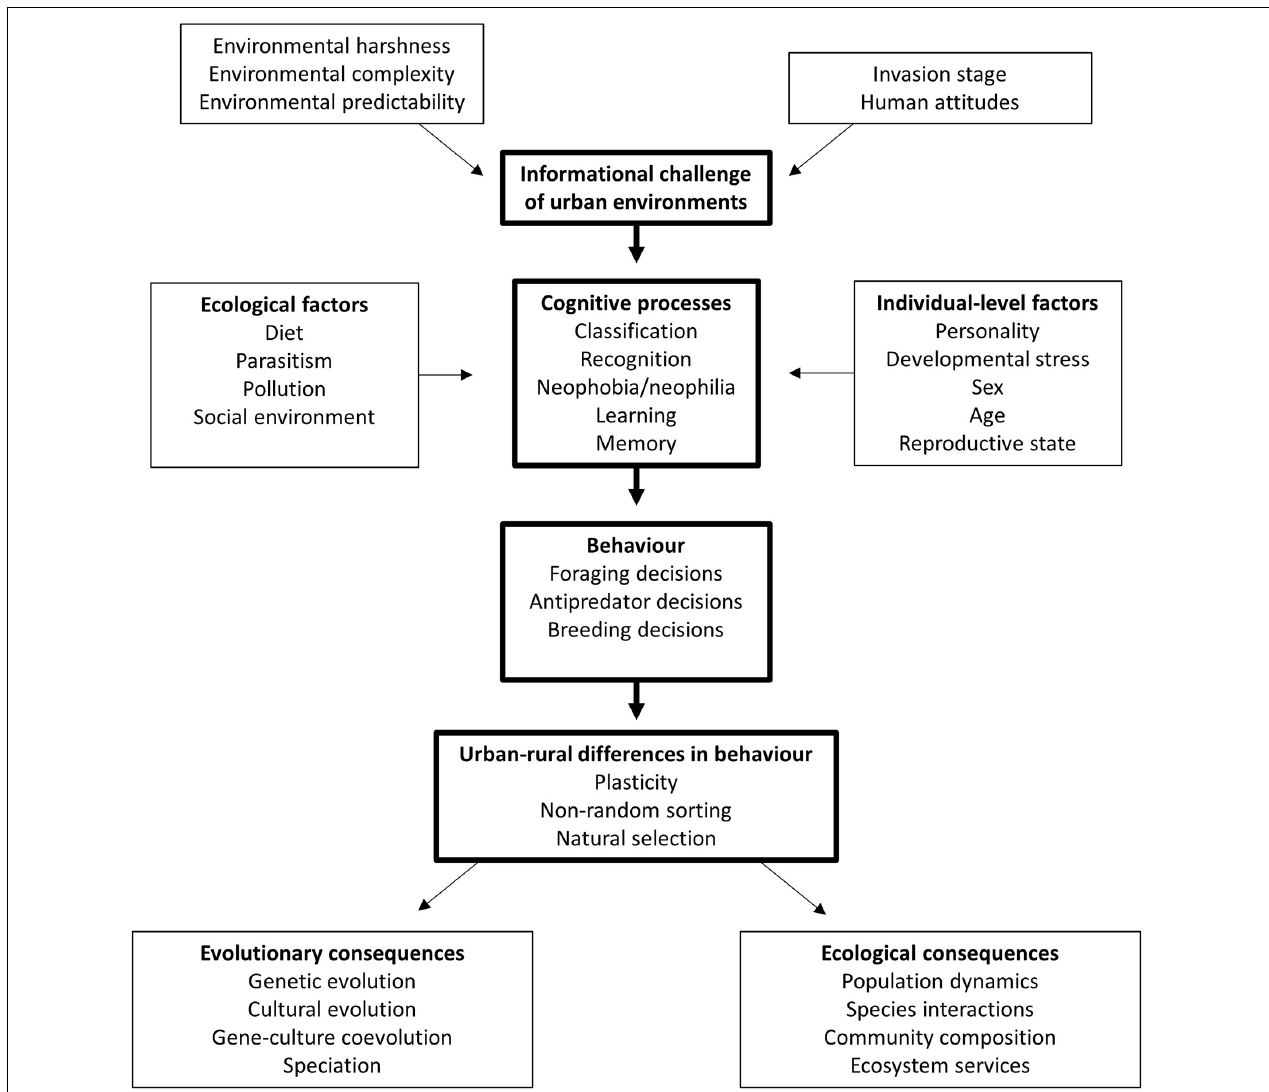
FIGURE 2 | Factors influencing cognitive variation in urban and non-urban habitats, and their consequences for ecological and evolutionary